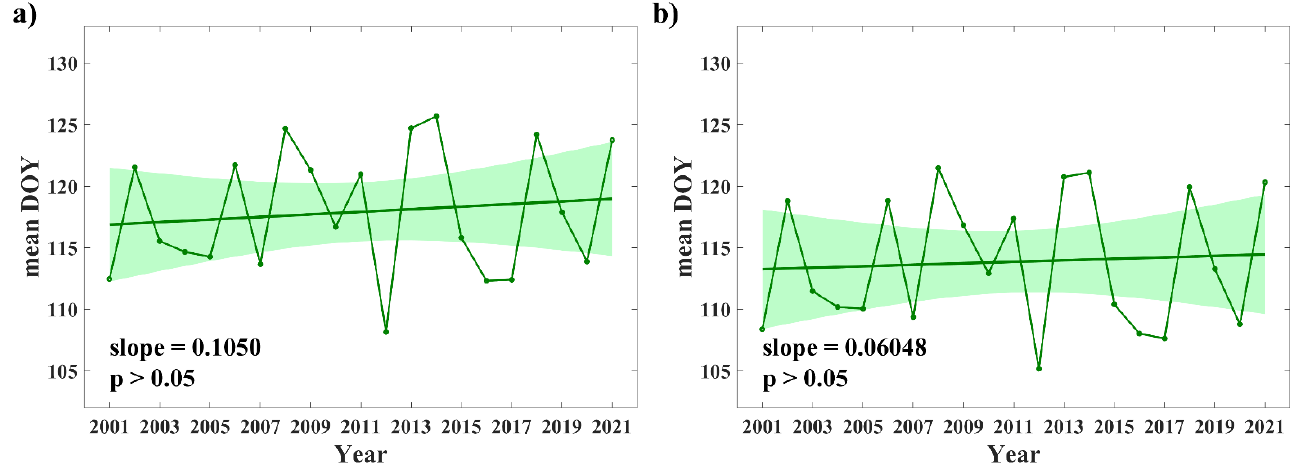
Figure 8. Temporal trend of annual mean SOS in the conterminous United States from 2001 to 2021, ( a ) indicates the annual mean SOS trend when cropland is included, and ( b ) indicates the annual mean SOS trend when cropland is excluded. The green solid line denotes the trend line, and the bar represents 95% confidence interval.